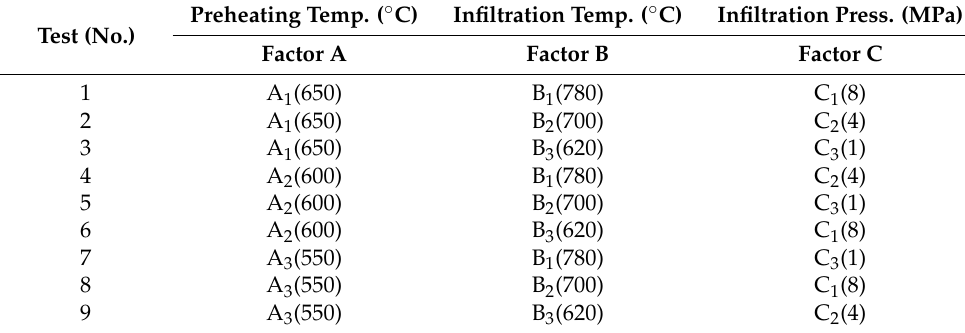
Table 2. The orthogonal test design.